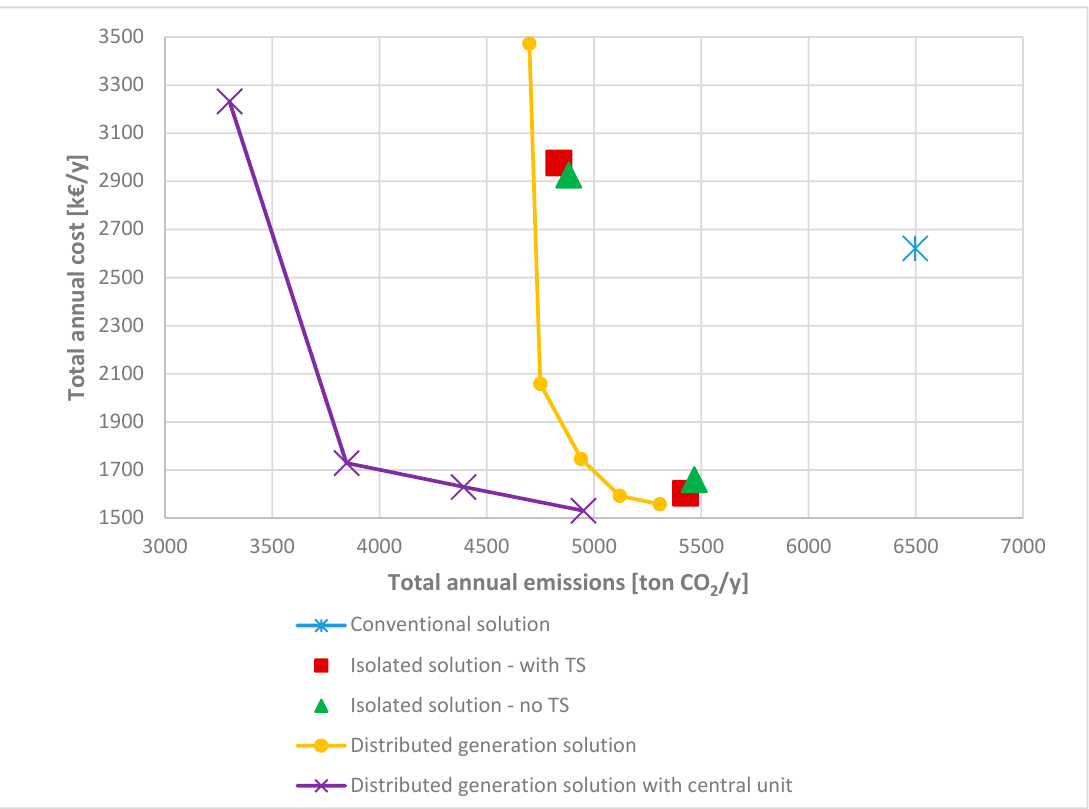
Figure 11. Pareto front of the optimal distributed generation solutions integrated with central solar system.